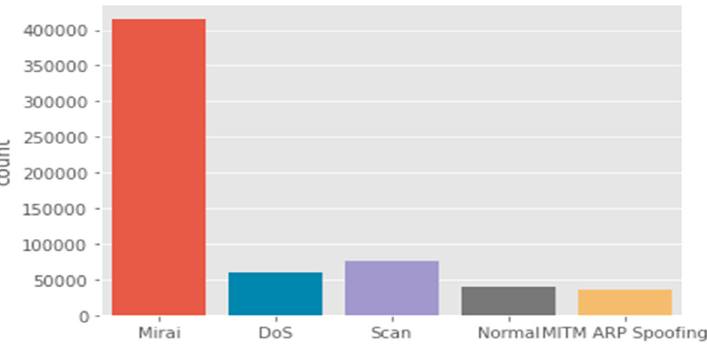
Figure 8. Services Distribution.